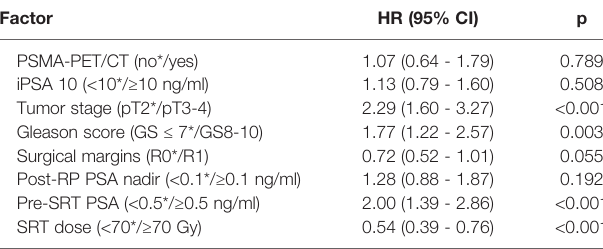
TABLE 2 | Multivariable Cox Regression Analysis on factors associated with biochemical recurrence free survival after SRT. Factor HR (95% CI) p PSMA-PET/CT (no*/yes)